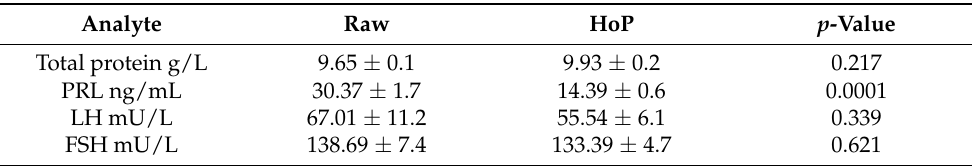
Table 3. Impact of Holder pasteurization on the concentrations of FSH, LH, and PRL in donor milk ( n =